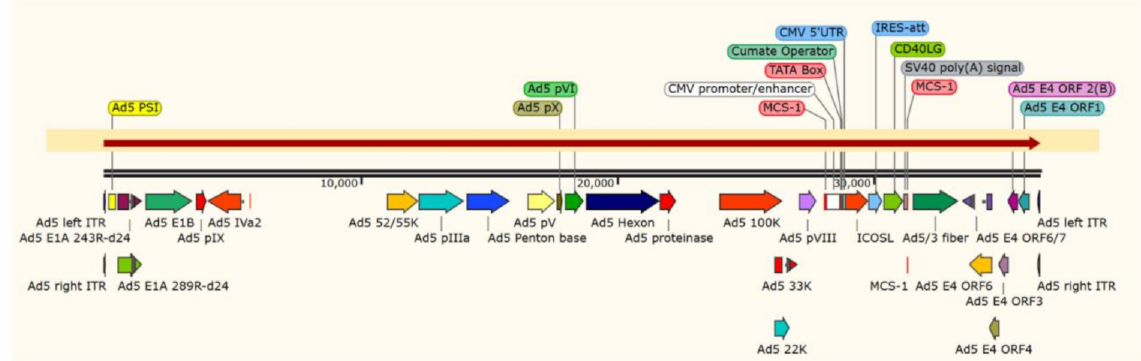
Figure 1. Viral DNA extraction from CsCl-purified virus particles using proteinase K. The AdV-D24-ICOSL-CD40L sequencing library was made using a Nextera XT kit (Illumina). The size of the library was assessed by high-resolution agarose gel electrophoresis. The presence of the 24-bp deletion in the E1A CR2 domain, the CMV-ICOSL-IRES-CD40L expression cassette inserted in place of the E3 region and the hybrid Ad5/3 fiber were confirmed. Analysis of sequence coverage did not detect the presence of a virus sub-population with a genome characterized by a major rearrangement such as a large insertion or deletion. The figure was generated by SnapGene ®